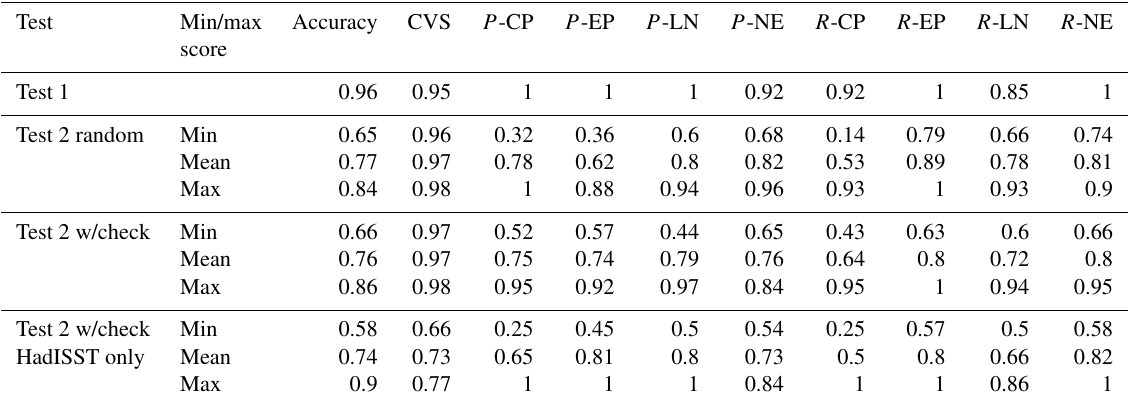
Table 3. Scores for the final ensemble classifier. Test 1 uses all available data, with HadISST kept aside for testing. Test 2 uses the longer datasets, ERSST, COBE, Kaplan, and HadISST, for training and testing. The data are split so that the augmented events must all occur in the same section of the data (i.e. training or testing). The data split is randomly completed 10 times on alternative splits of the training